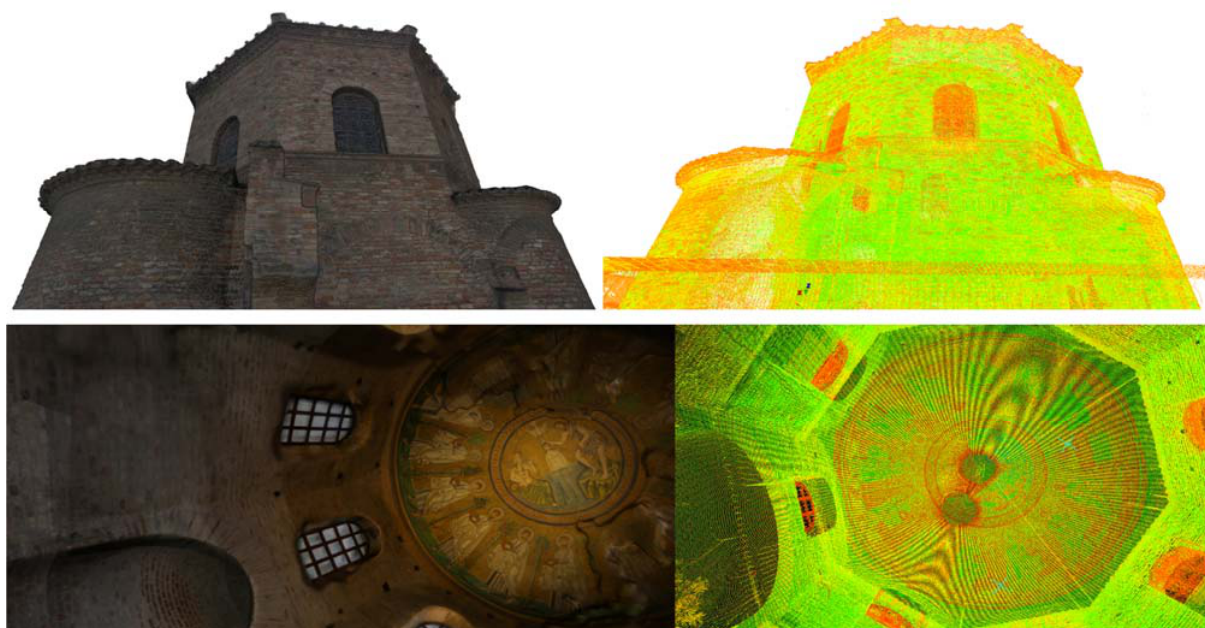
Figure 7. Left, textured 3D models of the inside and the outer surface of the Battistero degli Ariani built using the SfM approach. Right, point clouds derived from laser